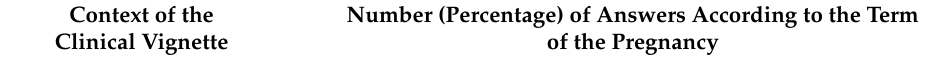
Table 4. Results of clinical scenarios of